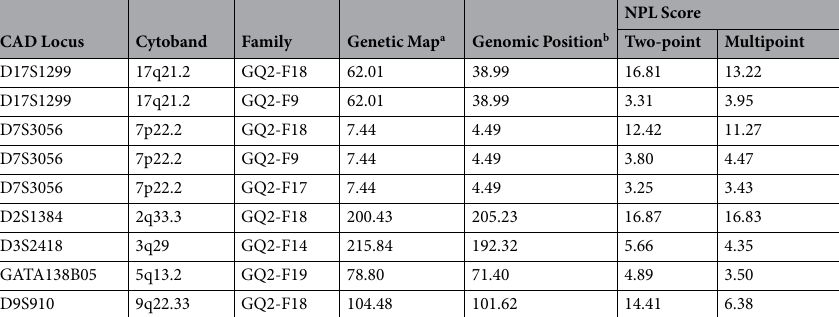
Table 3. Six Genetic Loci for CAD Confirmed by GWLS in Individual GeneQuest II Families. a The genetic map position was based on Marshfield Medical Genetic marker set 11. b Physical genomic position was retrieved from the UCSC database with human build